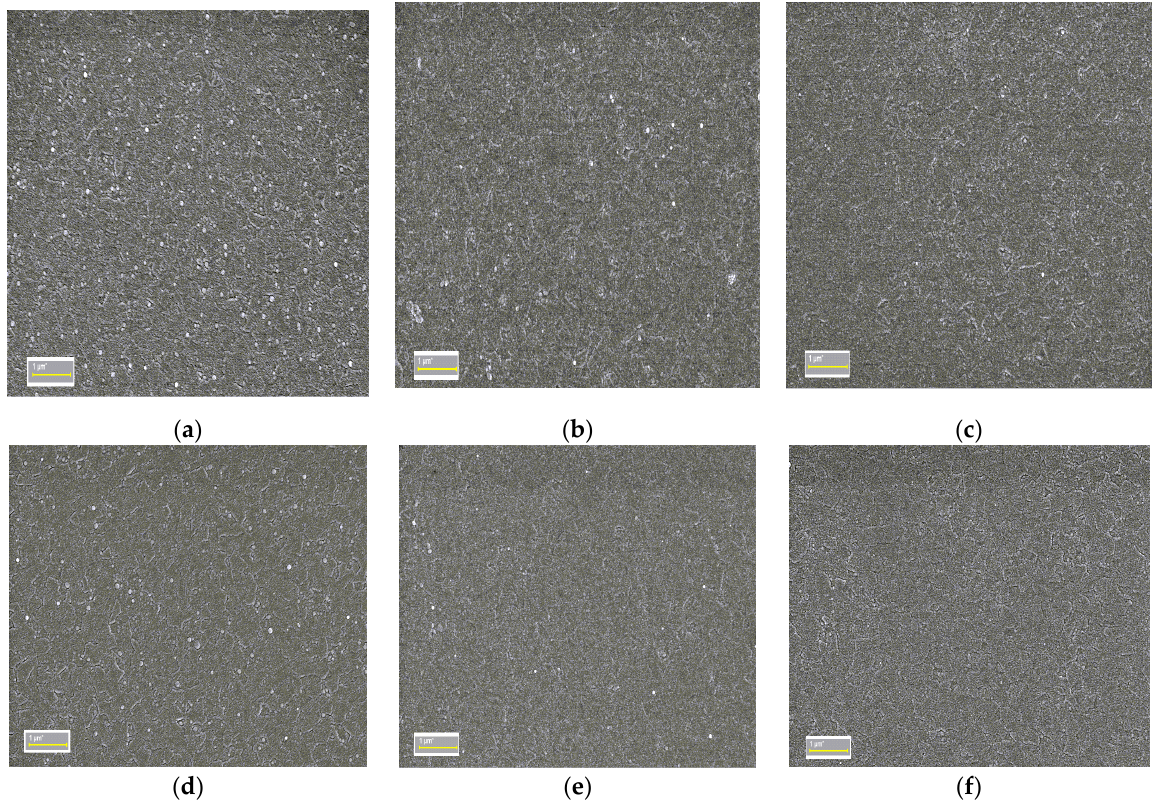
Figure 2. SEM images of TiO 2 thin films grown on ITO glass substrates by PLD, from targets sintered at different temperatures: ( a ) as 25-TiO 2 , ( b ) as 500-TiO 2 , ( c ) as 1000-TiO 2 , ( d ) ptt 25-TiO 2 , ( e ) ptt 500-TiO 2 and ( f ) ptt 1000-TiO 2 .